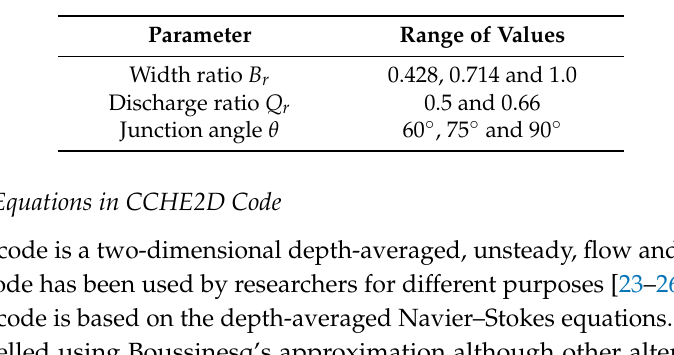
Table 2. Values of the parameters used in the experimental study from Ghobadian [8].